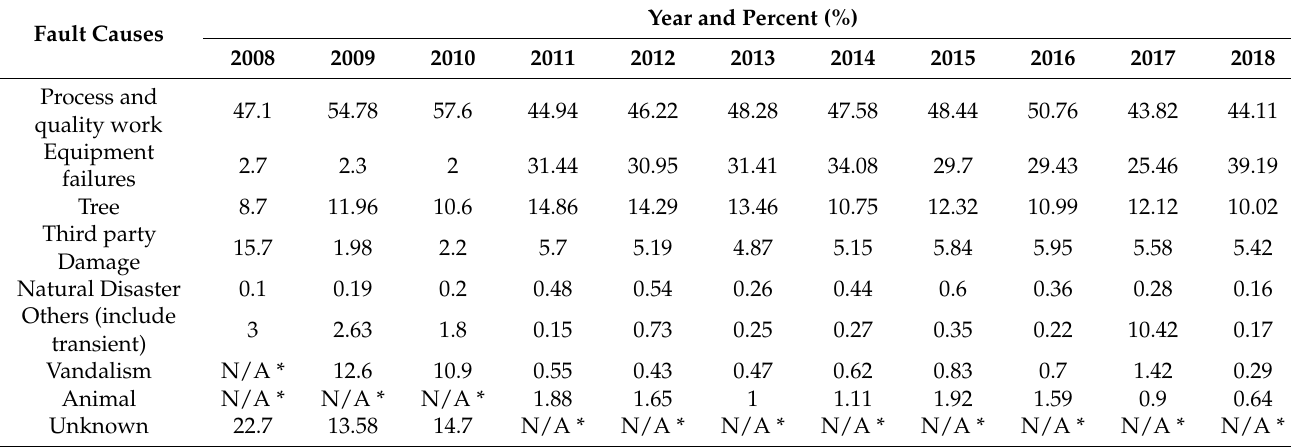
Table 2. Percentage of unscheduled electricity supply interruptions by fault causes (excluding high voltage interruptions) in Peninsular Malaysia